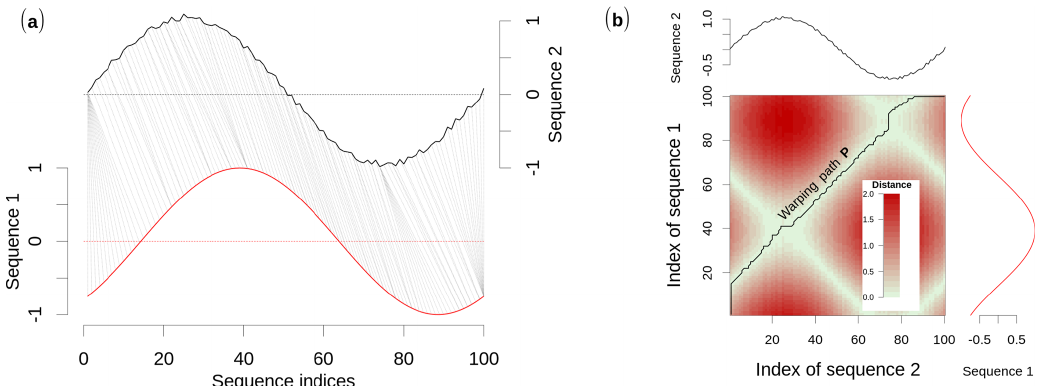
Figure 1. Illustrative example of the DTW alignment of two sine wave sequences. (a) Each element of the first sequence is mapped to one or many elements of the second sequence; the corresponding sequence elements can be found by (b) the (warping) path of least resistance through a local cost matrix that stores the distances between every possible pair of sequence